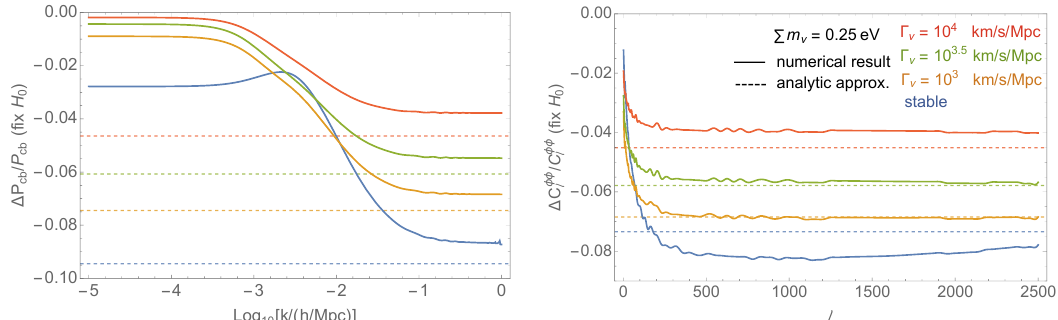
Figure 2 . Plots of the fractional di(cid:11)erence in the CDM+Baryon power spectrum P left ) and cb ( CMB-lensing potential C (cid:30)(cid:30) ( right ) for various decaying (and stable) massive neutrino scenarios ‘ with respect to the case of massless neutrinos. The solid lines show the results from numerical simulations of the decaying neutrino scenario for three values of the decay width, (cid:0) (cid:23) = 10 4 : 0 ; 3 : 5 ; 3 : 0 (km/s/Mpc) (top to bottom), and also the stable neutrino scenario, holding m (cid:23) = 0 : 25 eV and H 0 (cid:12)xed. The dashed lines represent the corresponding analytic estimates from section 4.2. P C l ϕϕ Σ m ν = 0.2eV, stable Σ m ν = 0.36eV, Γ ν = 10 4 km / s / Mpc